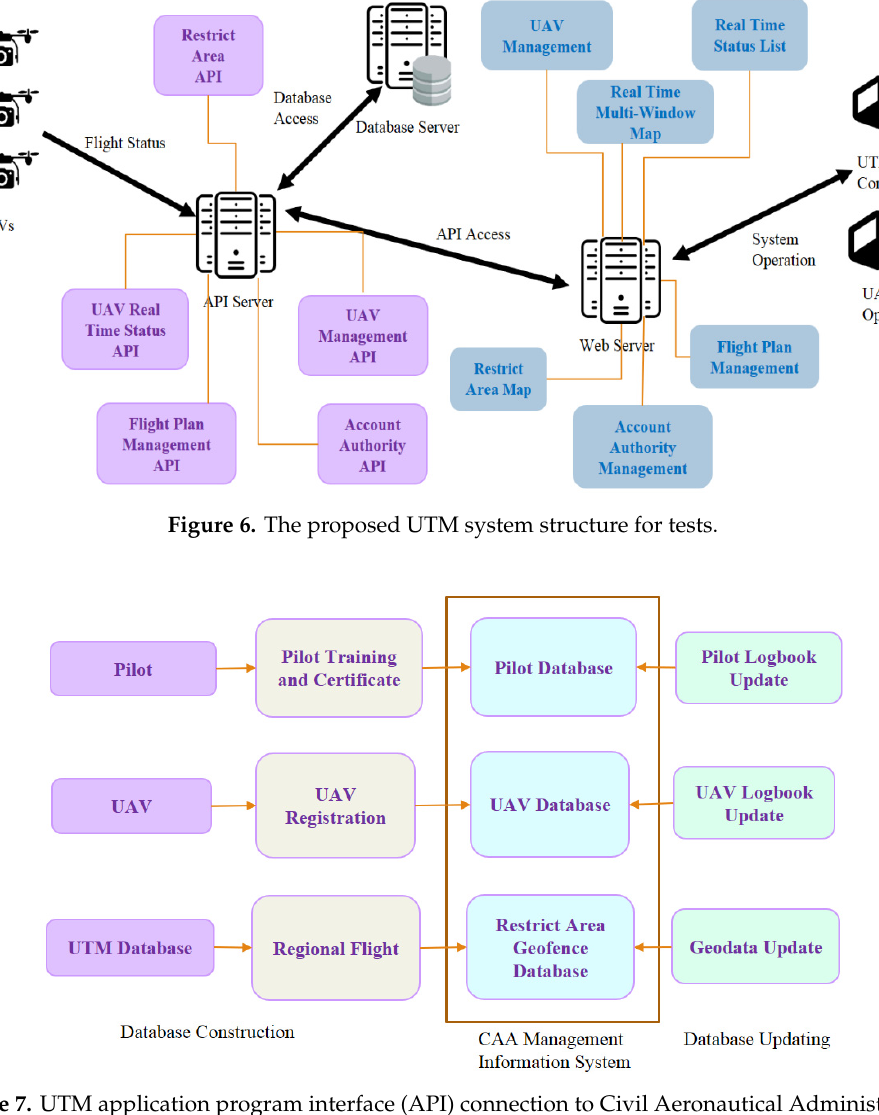
Figure 7. UTM application program interface (API) connection to Civil Aeronautical Administration (CAA) Management Information System (MIS).